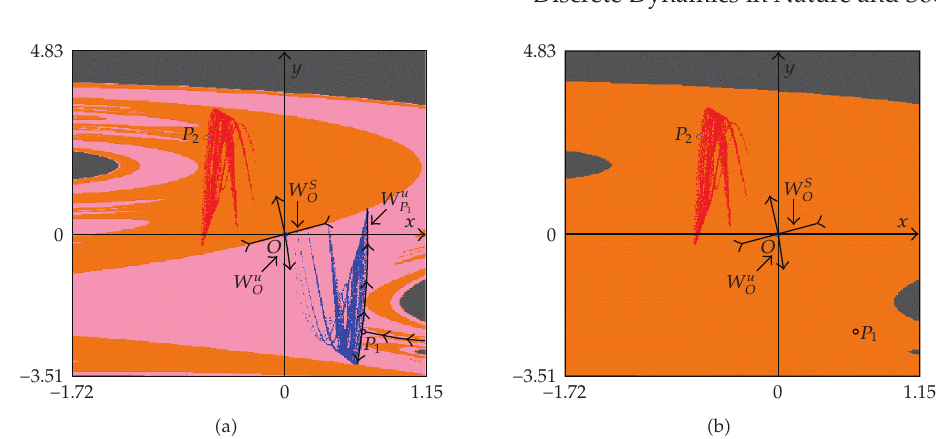
Figure 12: One-side homoclinic bifurcation of O . (cid:5) a (cid:6) shows the situation at the bifurcation value e (cid:4) 4 . 198, while (cid:5) b (cid:6) portrays a situation just after the bifurcation, at e (cid:8) 4 .